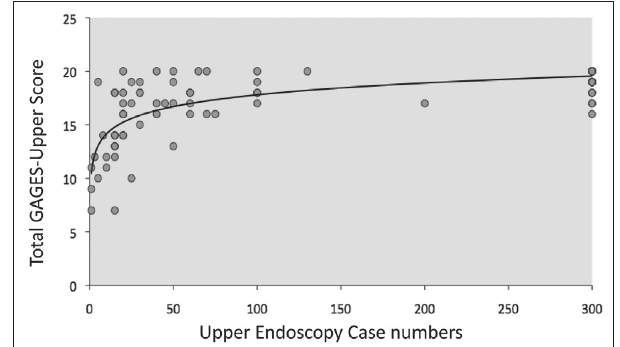
Figure 6) Using the Global Assessment of Gastrointestinal Endoscopic Skills ( GAGES) to access proficiency at upper gastrointestinal endoscopy. Reproduced with permission from reference 21